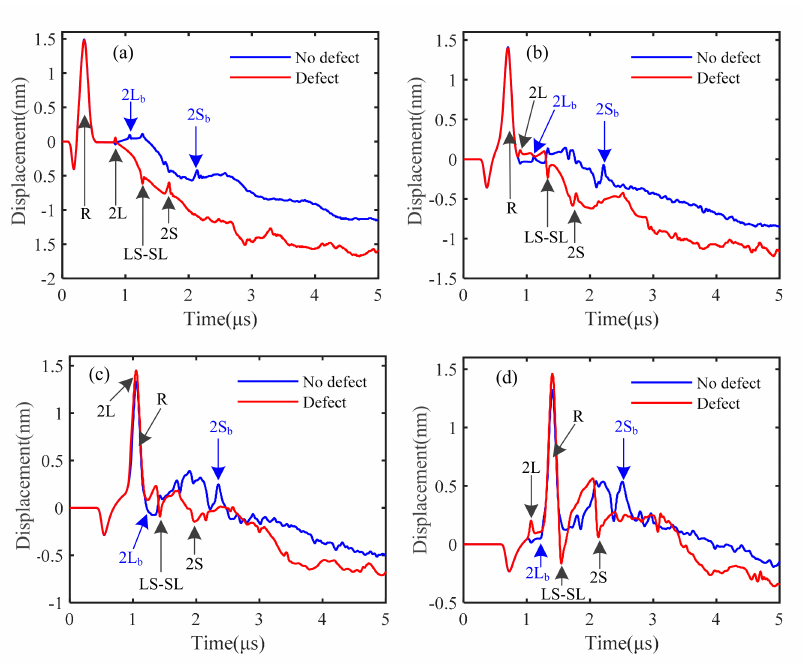
Figure 7. Comparison of laser ultrasonic waves in a model without defect and a model with delamination defect with different PRDs: ( a ) 1 mm, ( b ) 2 mm, ( c ) 3 mm, and ( d ) 4 mm.